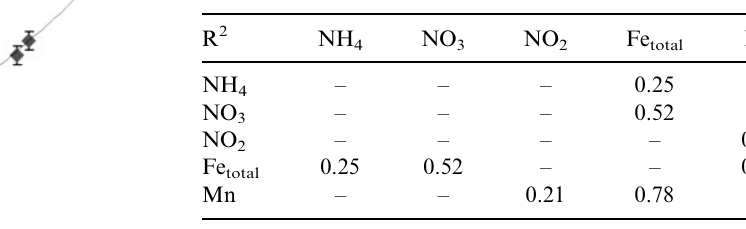
Table 3. Dependency between nitrogen compounds